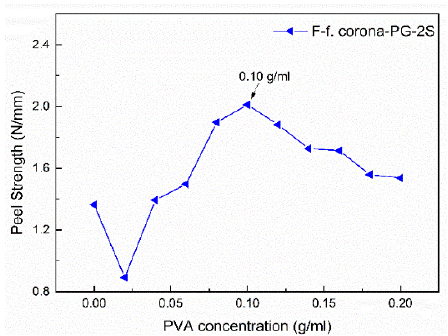
Figure 4. Peel Strength of the composite with different polyvinyl alcohol (PVA) concentration of the six methods.